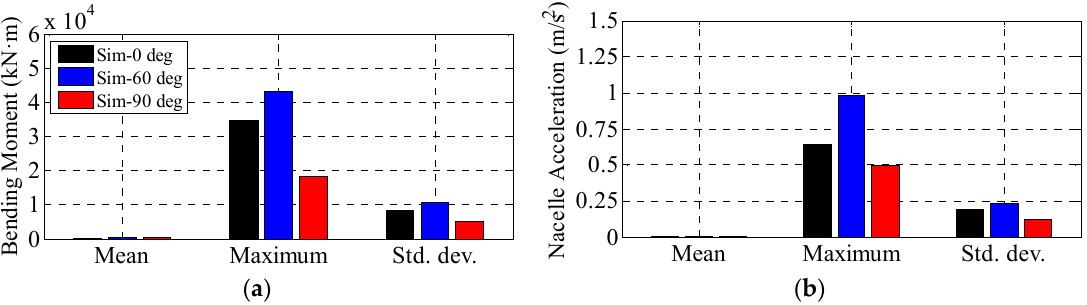
Figure 21. Statistical comparisons of ( a ) tower base bending moment and ( b ) nacelle acceleration between three wave headings.